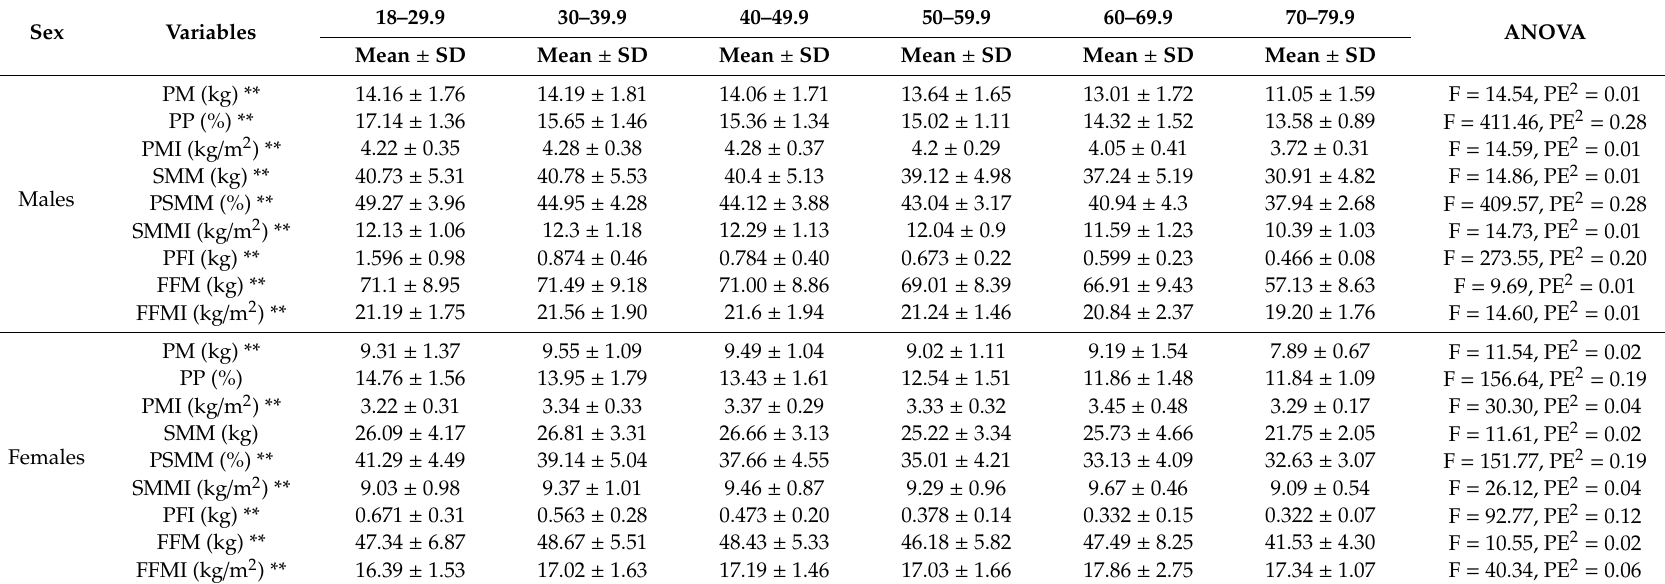
Table 1. Descriptive data according to gender and age